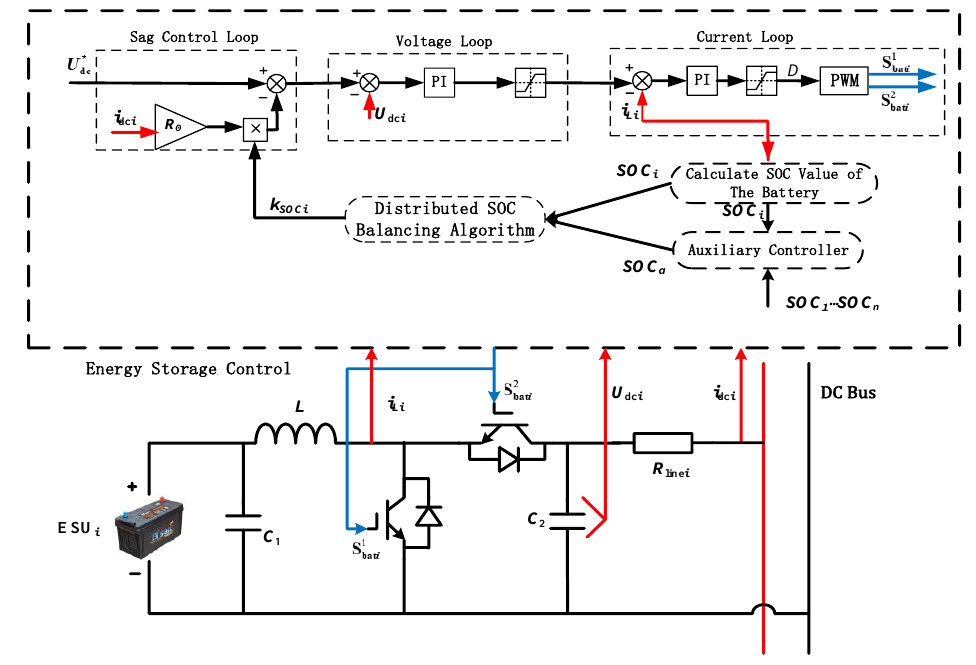
Figure 4. Distributed variable sag slope control